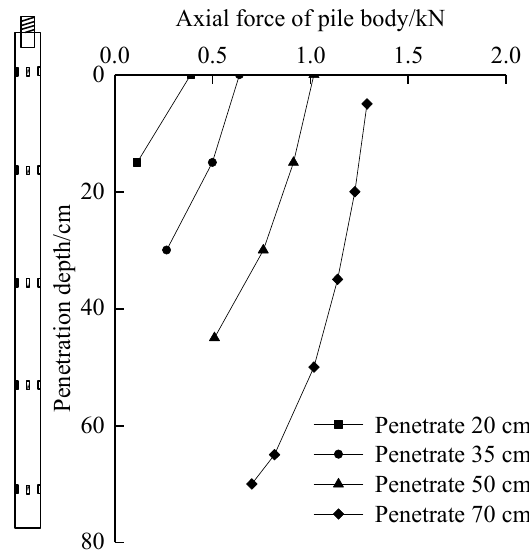
Figure 13. Pile axial force with penetration depth curve.